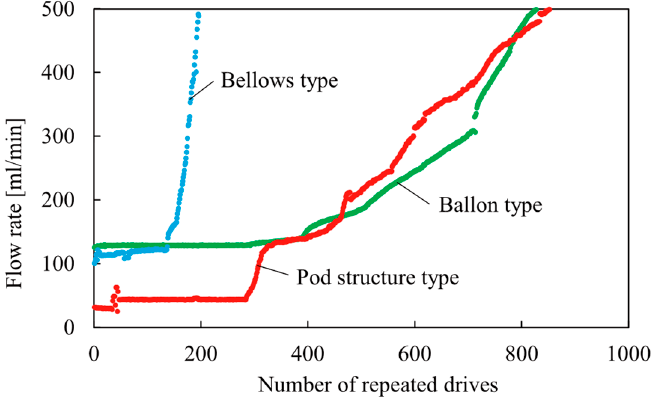
Figure 19. Relationship between the number of repetitive drives of each actuator and the flow rate.